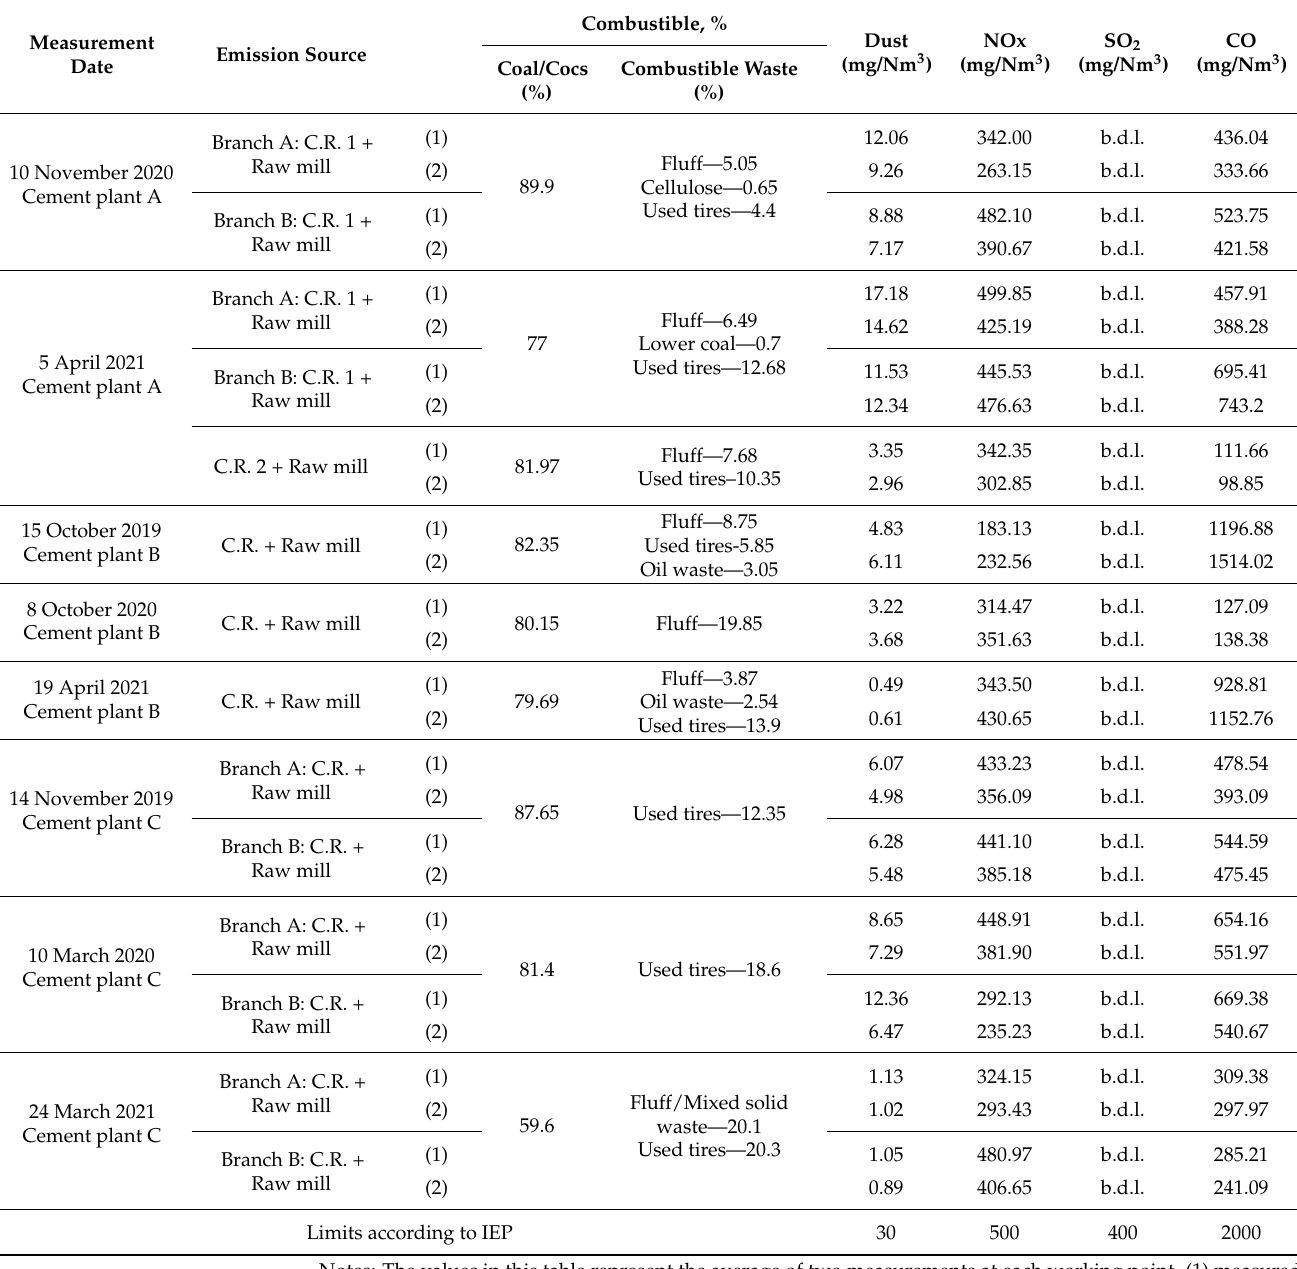
Table 1. Results on the composition of NOx, SO 2 , CO and dust in the stack of the clinker